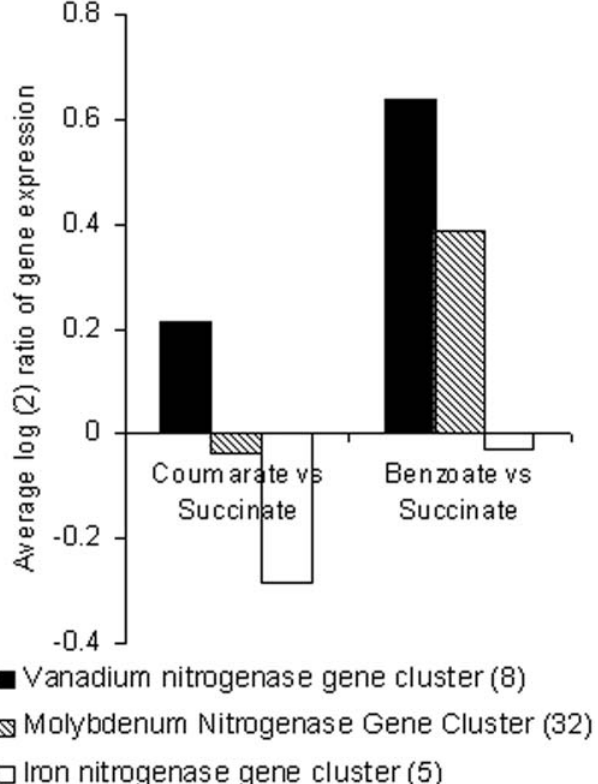
Figure 3. Average log2 ratio of the expression of nitrogenases with different cofactors in the growth on p-coumarate and benzoate versus succinate.